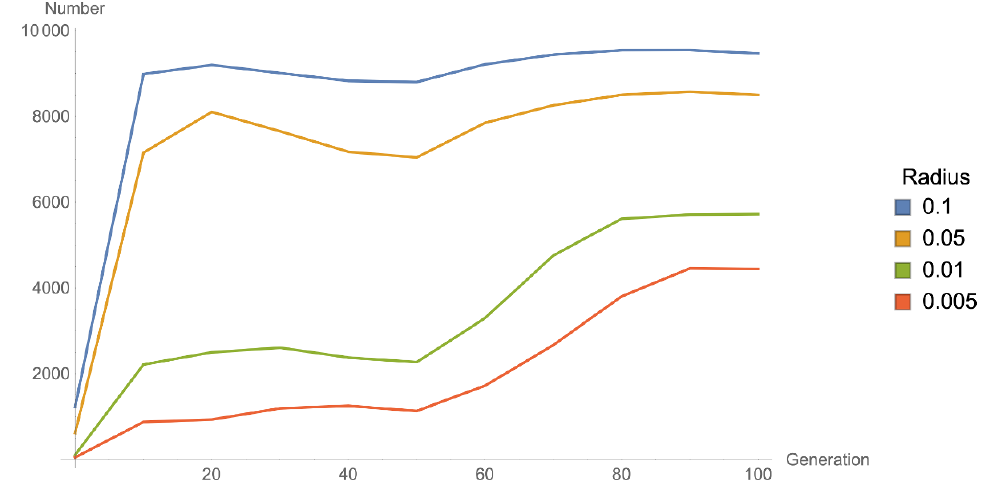
Figure 10 . Number of members in neighborhoods of di(cid:11)erent radius around g (cid:3)